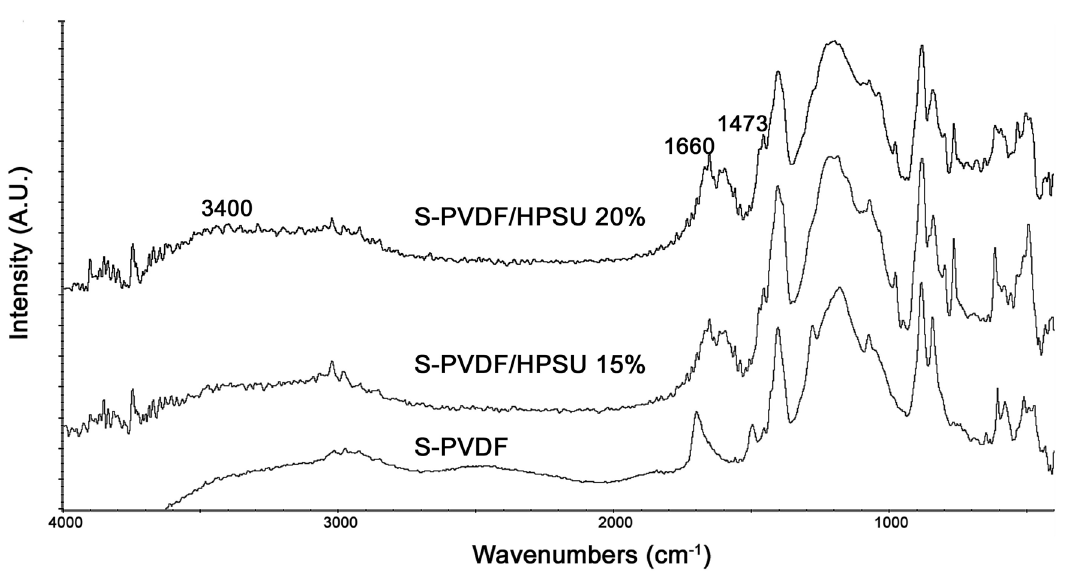
Figure 6. PA-FTIR Spectra of S-PVDF and the S-PVDF/HPSU composite.